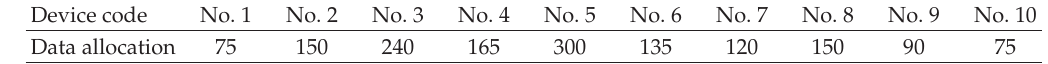
Table 3: Theoretical data allocation on 10 storage devices.